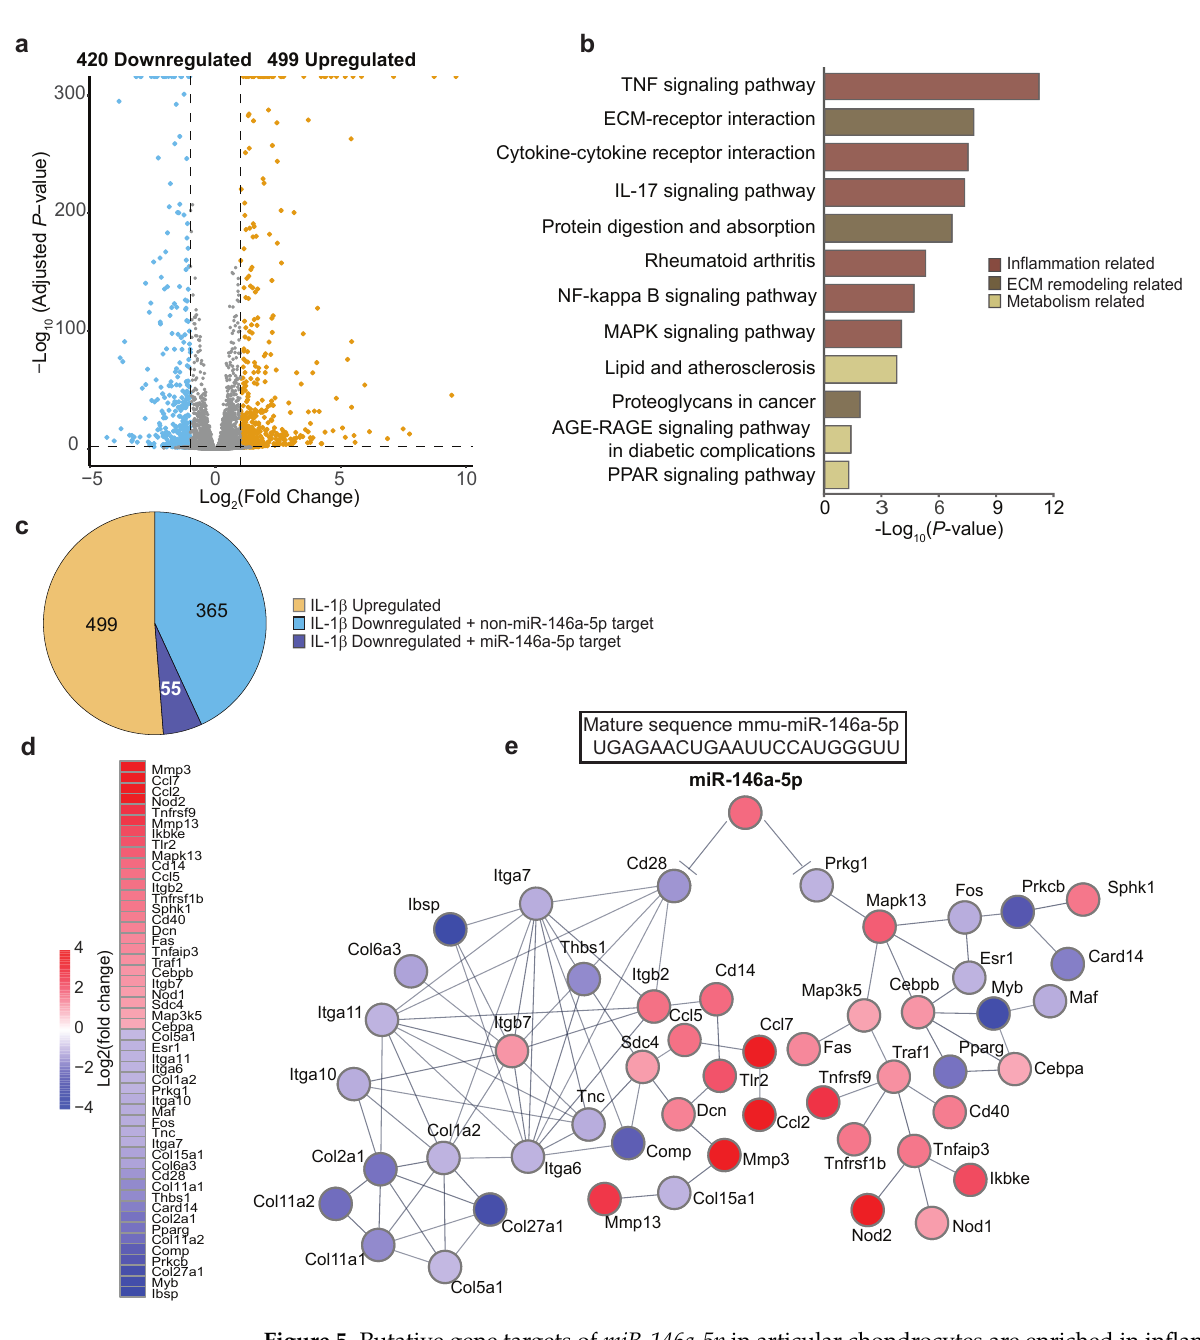
Figure 5. Putative gene targets of miR-146a-5p in articular chondrocytes are enriched in inflamma- tory pathways and cartilage matrix homeostasis. ( a ) Volcano plot of RNA-Seq showing the global transcriptional changes in IL-1 β - versus vehicle-treated primary murine articular chondrocytes (n = 4); ( b ) Significant enriched KEGG pathways ( p < 0.05) for differentially expressed genes (DEGs) (Log 2 FoldChange > 2, Padj < 0.05) between IL-1 β - and vehicle-treated groups (n = 4); ( c ) Pie chart in- dicating the significantly IL-1 β -regulated genes and putative gene targets predicted by the TargetScan web tool. Yellow represents IL-1 β -upregulated genes. Light blue represents genes that are down- regulated but not targeted by miR-146a-5p . Dark Blue represents genes that are downregulated and potentially targeted by miR-146a-5p in primary murine articular chondrocytes (n = 4); ( d ) Functional association network of miR-146a-5p and its gene targets linked to two major biological functions, inflammatory responses, and cartilage matrix homeostasis (n = 4); ( e ) Heatmap of DEGs illustrated in protein–protein interaction network (n =